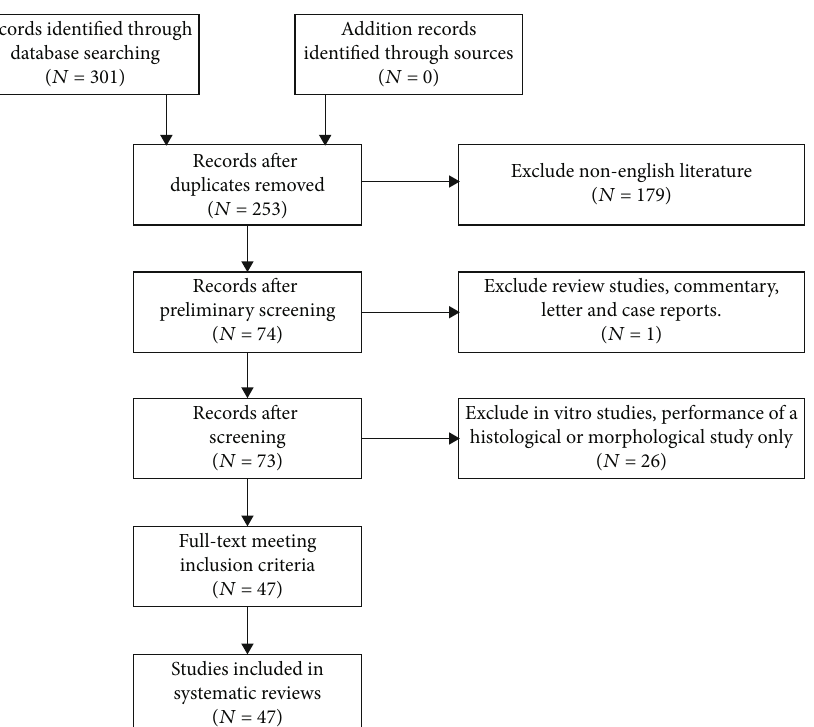
Figure 1: Flow diagram of the search process and search